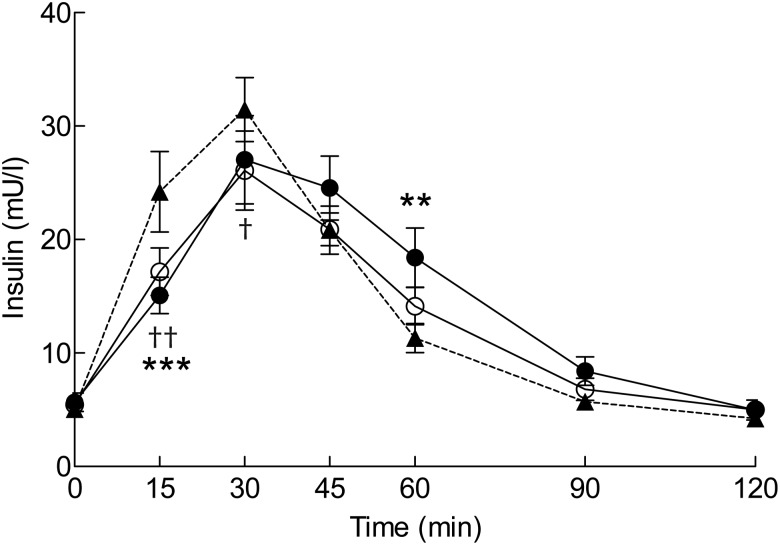
Plasma insulin concentrations after ingestion of the test products: reference (▲); blackcurrant nectar (●); lingonberry nectar (○). Values are means (n 18), with standard errors represented by vertical bars. P < 0·001 for product  ×  time interaction in the mixed-model analysis. Mean value for the blackcurrant nectar was significantly different from that of the reference at an individual time point: ** P < 0·01, *** P < 0·001 (post hoc analysis with Sidak adjustment). Mean value for the lingonberry nectar was significantly different from that of the reference at an individual time point: † P < 0·05, †† P < 0·01 (post hoc analysis with Sidak adjustment). To convert insulin in mU/l to pmol/l, multiply by 6·945.